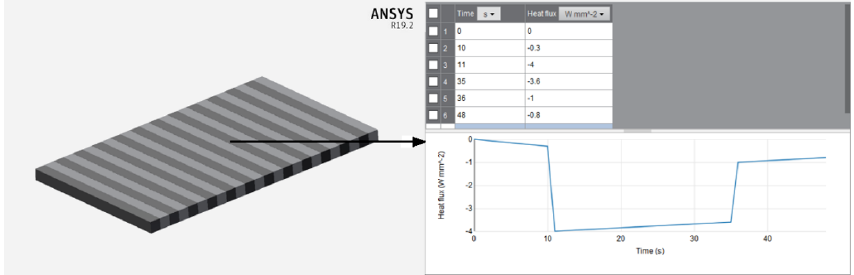
Figure 8. The boundary condition for the 10 th volume of the 6061 aluminium alloy